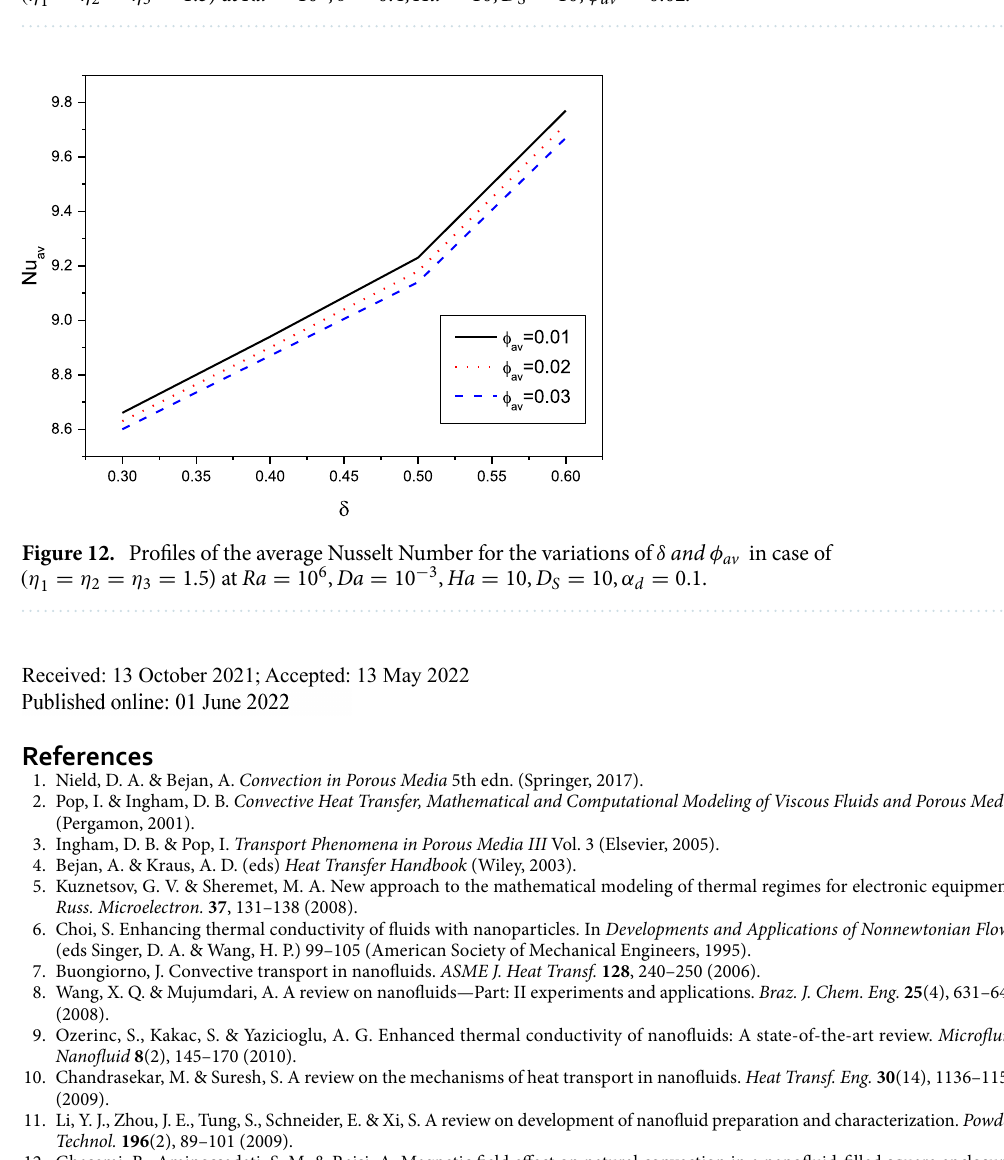
10 6 , δ 0.4, Ha 10, D 10, φ 0.02 . S = av = = = =